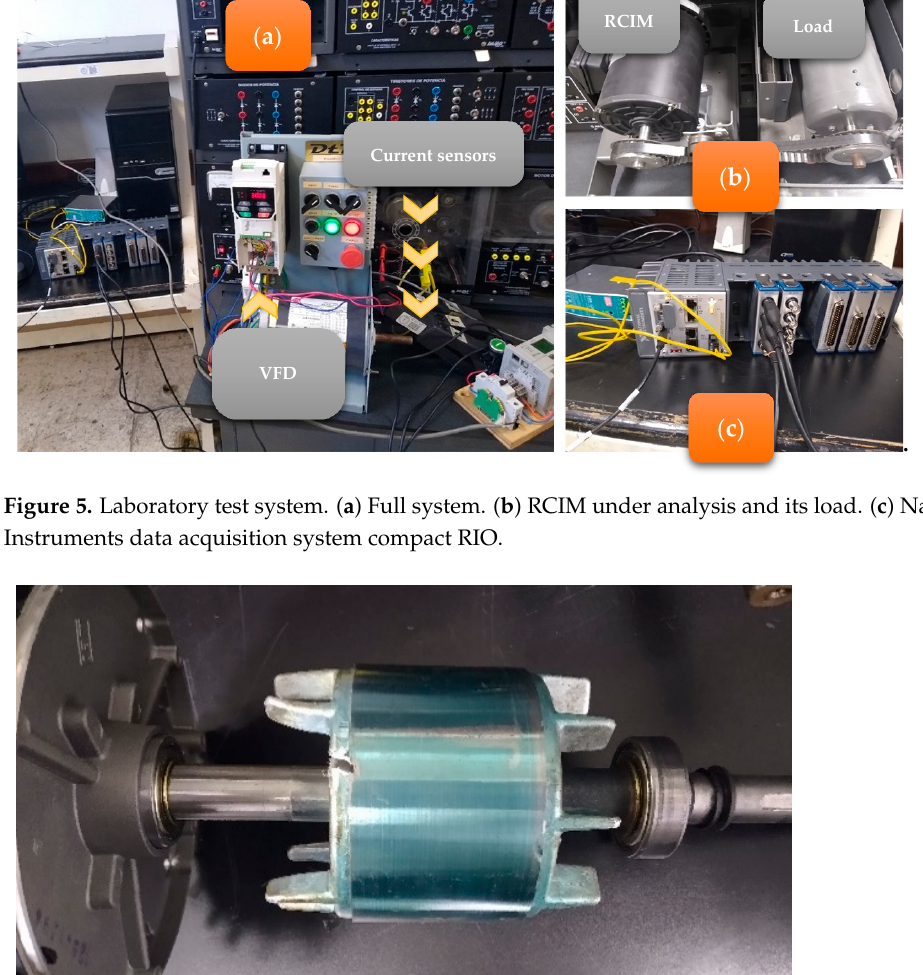
Figure 6. RCIM cracked ring rotor and broken rotor bar for analysis.